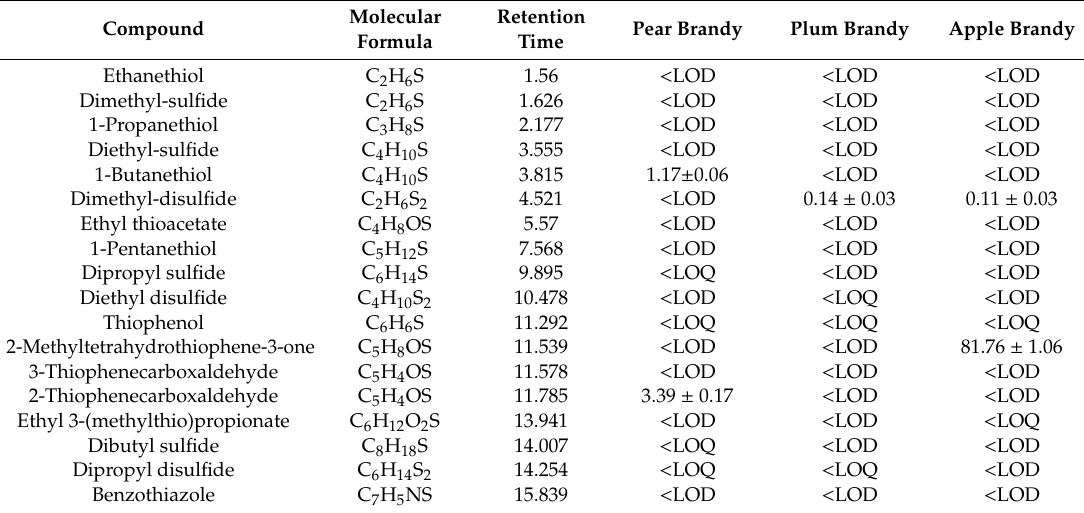
Table 4. Average concentration ( µ g / L) of VSCs found in tested brandy samples. Molecular Compound